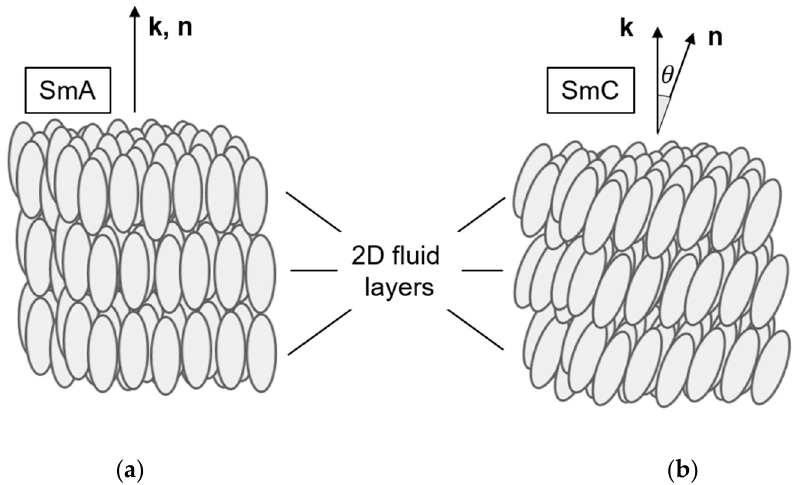
Figure 1. Structures of the fluid smectic phases ( a ) smectic A (SmA) and ( b ) smectic C (SmC). Both phases are 1D stacks of 2D fluid layers formed by orientationally ordered mesogenic molecules. In SmA, the director n (the mean direction of the long molecular axes) is parallel to the smectic layer normal k (the stacking direction of the layers). In SmC, n is tilted with respect to k by the director tilt angle θ .